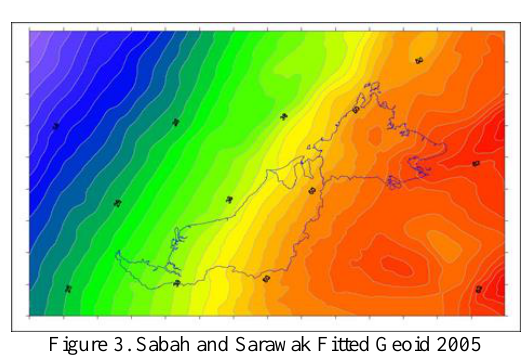
Figure 3. Sabah and Sarawak Fitted Geoid 2005